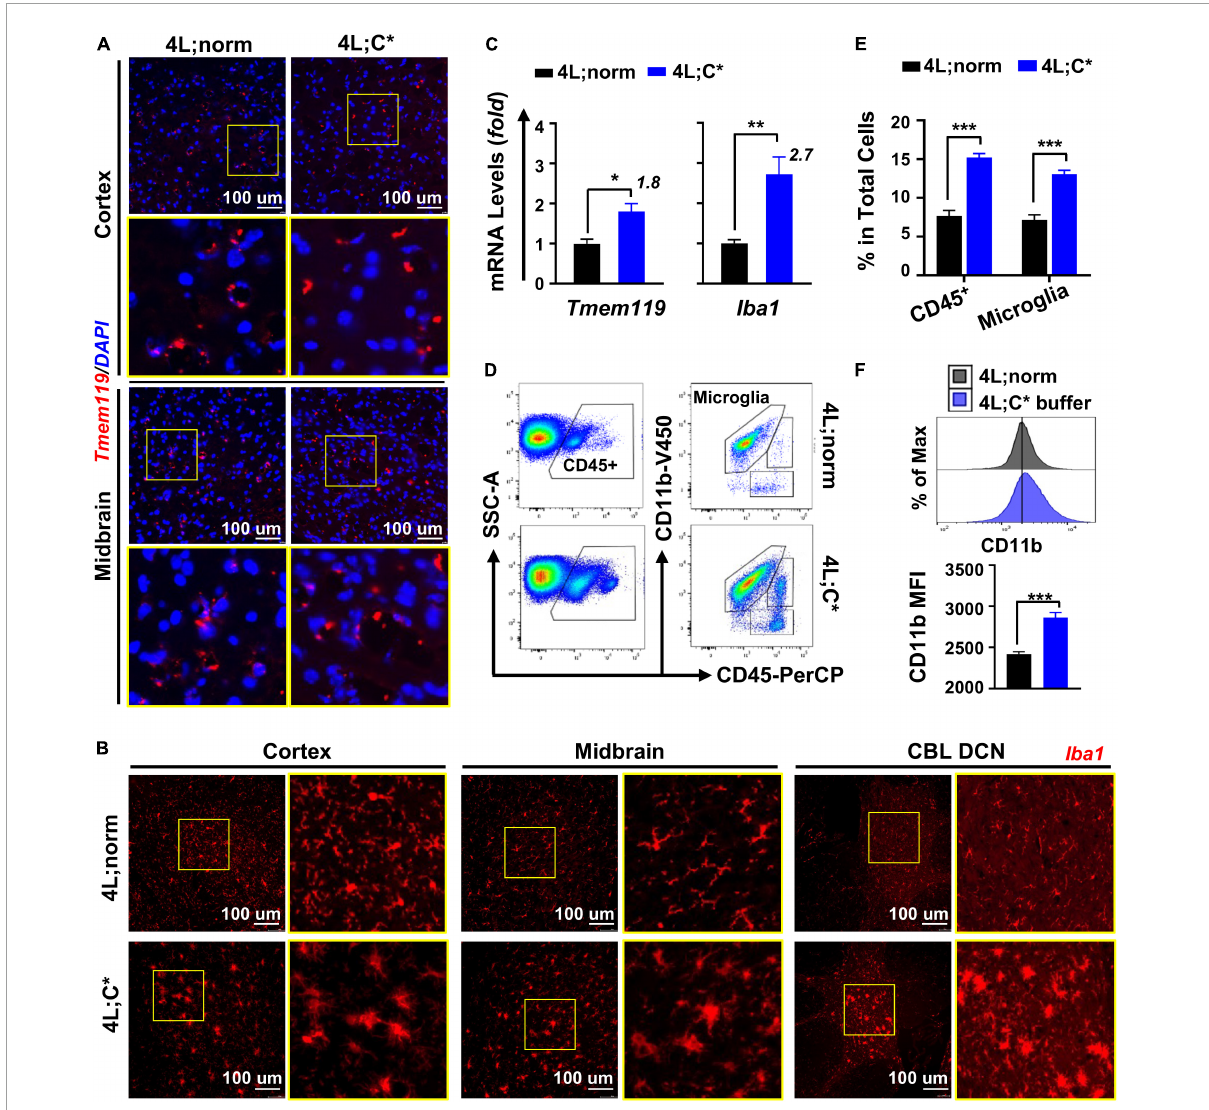
FIGURE1 Microglia showed abnormal elevation in both the numbers and activation status in 4L;C* brain. (A,B) Immunofluorescent analysis for microglial cells with anti-Tmem119 (red in A ) or anti-Iba1 (red in B ) and DAPI for nucleus (blue). (C) Relative mRNA expression of Tmem119 and Iba1 by RT-qPCR analysis using midbrain samples. N = 4 for each group. (D) Representative dot plots of FACS analysis with staining for microglia (CD11b + CD45 intermediate ) using cells isolated from brain hemispheres. (E) Quantitative analysis of CD45 + cells and microglia in total mononuclear cells obtained from half brain. (F) Mean florescent intensity (MFI) for CD11b expression in microglial cells. Representative histogram plots are shown (top) with quantitative analysis in each group (bottom). N = 12–18 for each group in (E,F) . Data are presented (in C,E,F ) as mean ± SEM. * p ≤ 0.05, ** p ≤ 0.01, and *** p ≤ 0.001 by Student’s t